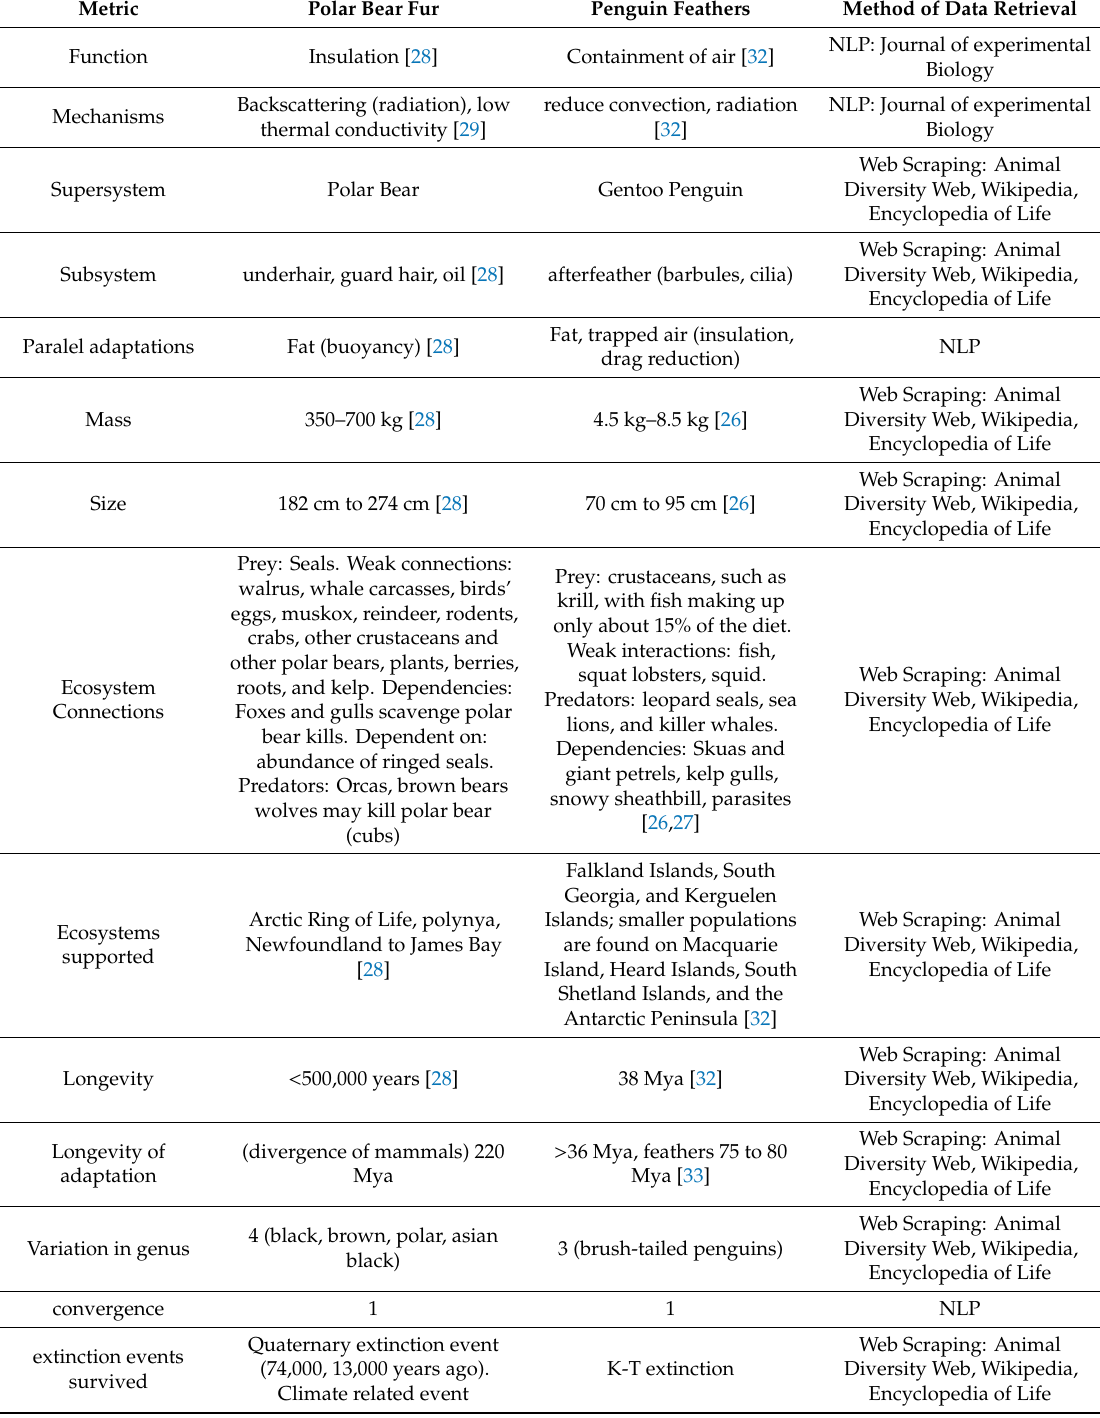
Table 1. Metrics for characterization of natural